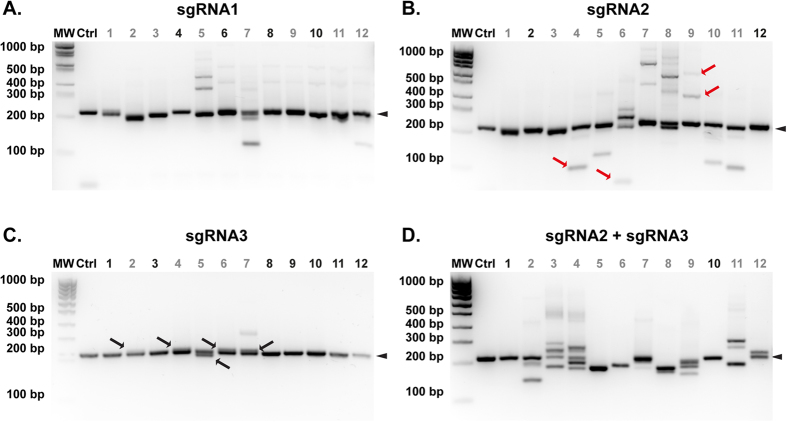
The profile of indels alleles is determined by the sgRNA.Agarose gel electrophoresis analysis of NleF-NleR PCR products of one non-injected embryo (Ctrl) and twelve embryos (lanes 1 to 12) microinjected into the pronucleus with either Cas9 mRNA/sgRNA1 (A), Cas9 mRNA/sgRNA2 (B), Cas9 mRNA/sgRNA3 (C), or Cas9n mRNA/sgRNA2 and 3 (D). Large deletions (>100 bp) and insertions (red arrows in B) are frequently observed with Cas9 mRNA/sgRNA2 while small (<10 bp) deletions and insertions (black arrows in C) are frequently observed with Cas9 mRNA/sgRNA3. Arrowheads point to the wild-type band (180 bp). MW: 100 bp molecular weight marker. Embryos with indels and wild type only alleles are labeled in gray and black respectively.